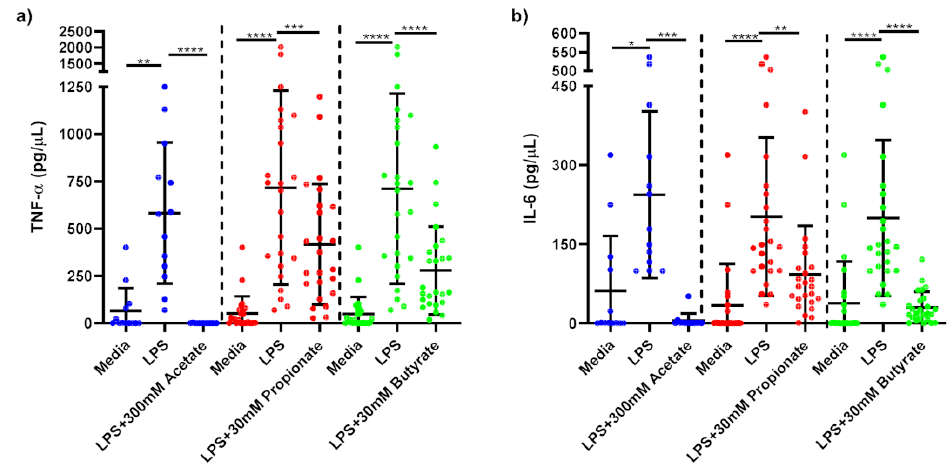
Figure 3. Cytokine response of LPS-stimulated monocytes following short-chain fatty acid treatments. Cell culture supernatant concentrations of ( a ) TNF- α (pg/ µ L); ( b ) IL-6 produced by monocytes stimulated with LPS (1 ng/mL) alone or treated simultaneously with sodium acetate ( n = 13) 300 mM or sodium propionate ( n = 24) 30 mM or sodium butyrate ( n = 25) 30 mM following 15 h incubation. Parametric data analysed by RM one-way ANOVA and post hoc analysis Tukey’s multiple comparison test, non-parametric by the Friedman test and post hoc analysis by Dunn’s multiple comparisons test. TNF- α ; tumour necrosis factor- α , IL-6: interleukin 6, LPS; lipopolysaccharide, Ac; acetate, Pr; propionate, Bu; butyrate. * p < 0.05, ** p < 0.01, *** p < 0.001 and **** p < 0.0001. Data expressed as the mean